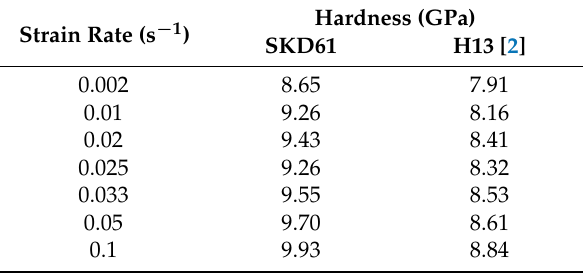
Figure 3. Indentation stress as a function of the strain rate for PBF processed by SKD61 and H13. Table 1. Hardness values of SKD61 and H13 prepared by the PBF process at the same scan speed of 800